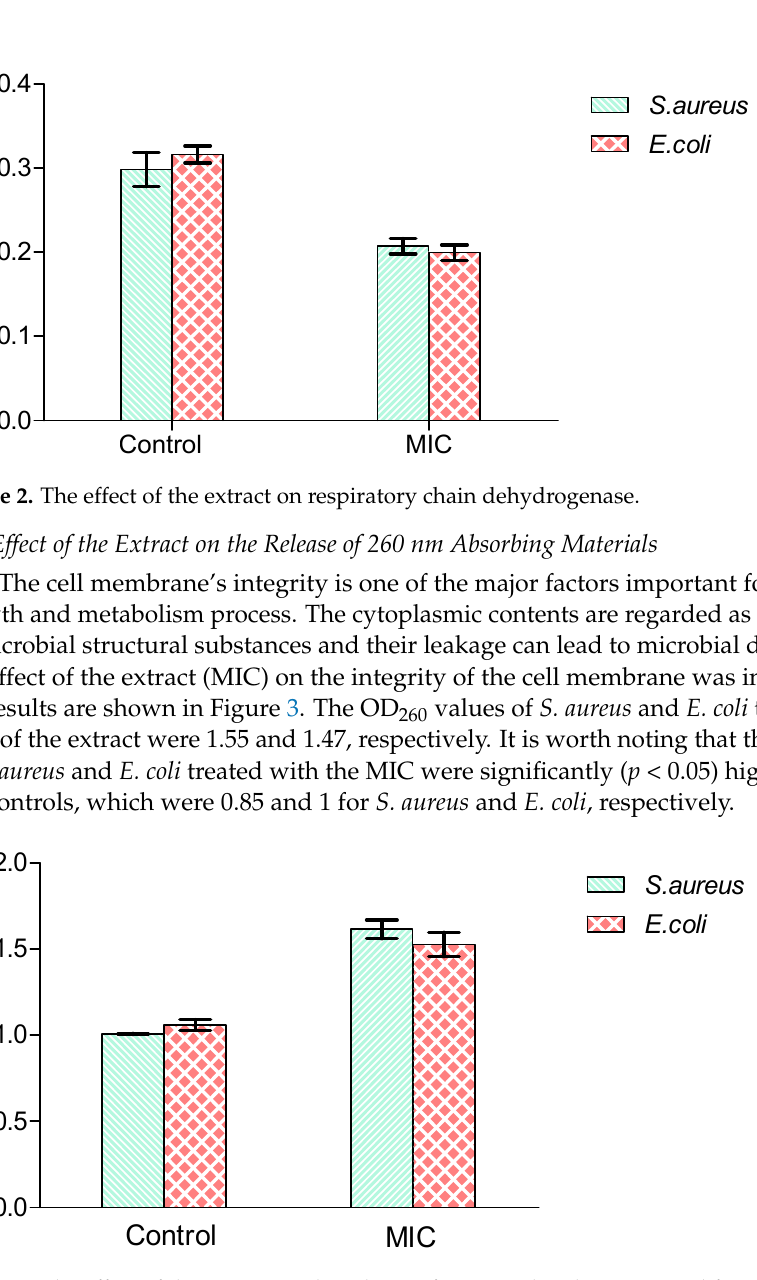
Figure 3. The effect of the extract on the release of 260 nm absorbing material from bacterial strains .